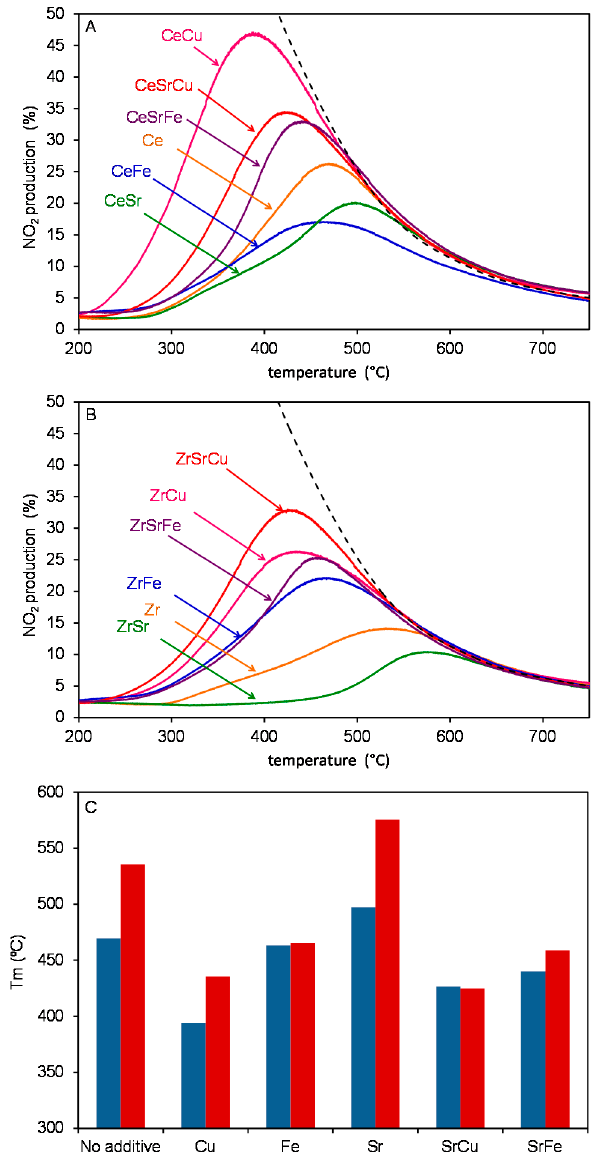
Figure 5. NO 2 production profile for ( A ) Ce ‐ and ( B ) Zr ‐ based catalysts; ( C ) NO oxidation activity: for CeO 2 support ( blue ), ZrO 2 support ( red ).